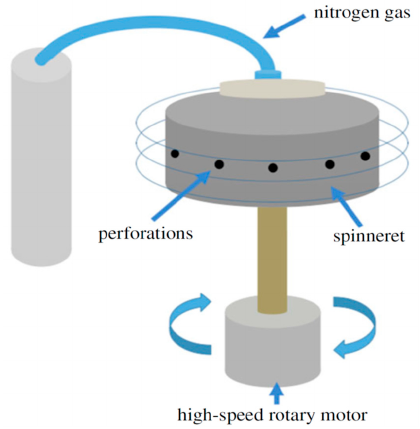
Figure 5. Schematic diagram of the pressurized gyration system for fabricating polymer fibers. Reproduced with permission from [44]. Copyright Royal Society, 2018.